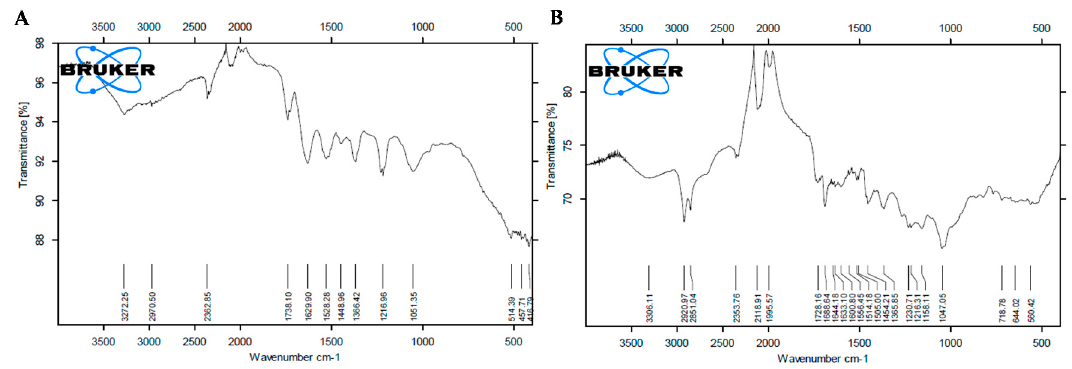
Figure 3 ( A ) FT-IR image of BC-AgNPs ( B ) FT-IR image of AE-AgNPs. Figure 3. ( A ) FT-IR image of BC-AgNPs ( B ) FT-IR image of